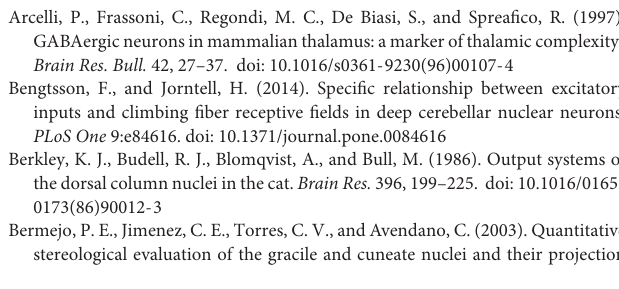
Supplementary Figure 1 | (A) Schematic of the rat forepaw showing the placement of the four pairs of stimulation electrodes (color coded). (B) The eight stimulation patterns used as the tactile inputs. Each color corresponds to a stimulation channel as indicated in (A)